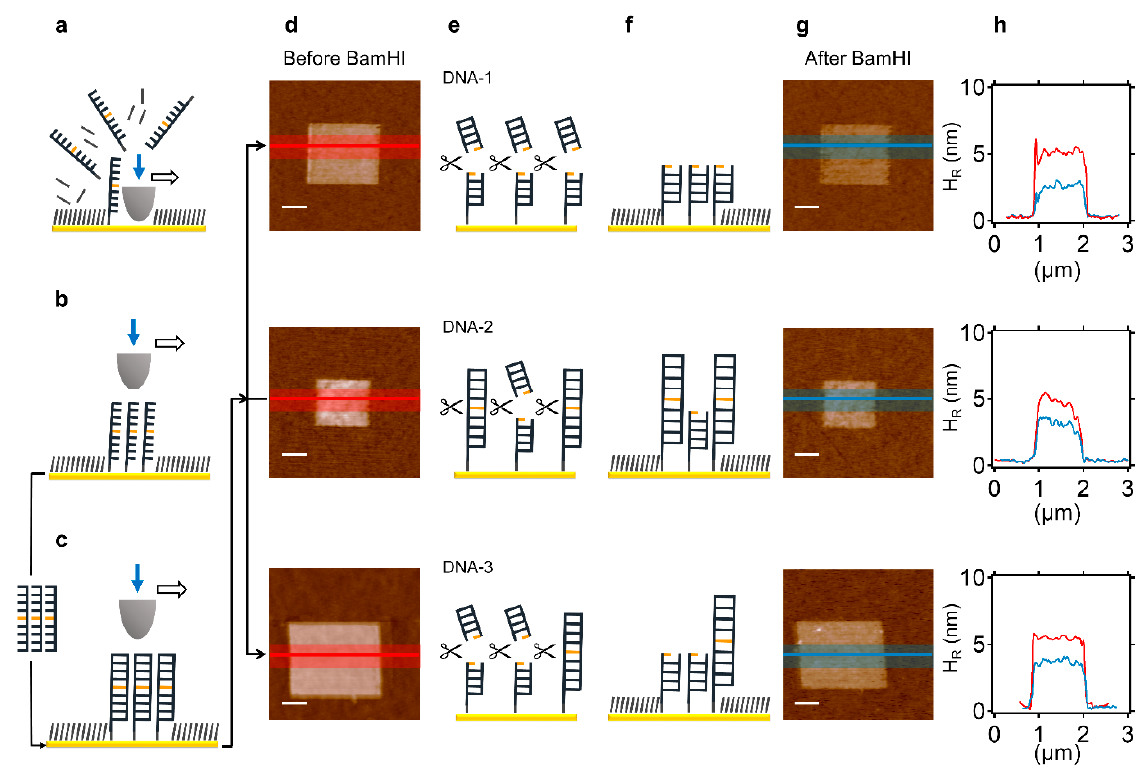
Figure 1. Noncanonical BamHI action in nanografted LCDMs at an intermediate DNA density. ( a ) Nanografting process: at a high applied load (~120 nN), the AFM tip displaces ethylene glycol-terminated alkylthiol molecules from a pre-selected area, consequently allowing immobilization of thiol-modified ssDNA molecules from the contacting solution. ( b ) After washing, a fully comple- mentary ssDNA is added, allowing the formation of dsDNA containing a centrally positioned REase recognition site (depicted in orange). ( c ) Topographic imaging is carried out at a low applied force (~0.2 nN) to register the LCDM height before BamHI reaction, using the surrounding alkylthiol SAM as an inert topographic reference. ( d ) AFM micrograph of an LCDM comprising DNA-1 (top), DNA- 2 (middle), or DNA-3 (bottom). ( e ) Schematic representation of the BamHI reaction on an LCDM, creating shortened, surface-bound dsDNAs with high efficiency for DNA-1 (top) or partially effi- ciency for both DNA-2 (middle) and DNA-3 (bottom) ( f ). ( g ) The same AFM micrograph in ( d ) is imaged after BamHI reaction. ( h ) Average topographic line profiles of the LCDM before (( d ), red) and after (( g ), blue) BamHI action, showing a ~45% height decrease for DNA-1 (top), ~23% for DNA- 2 (middle), and ~33% for DNA-3 (bottom). The scale bar (white) shown in all the AFM micrographs is 500 nm.